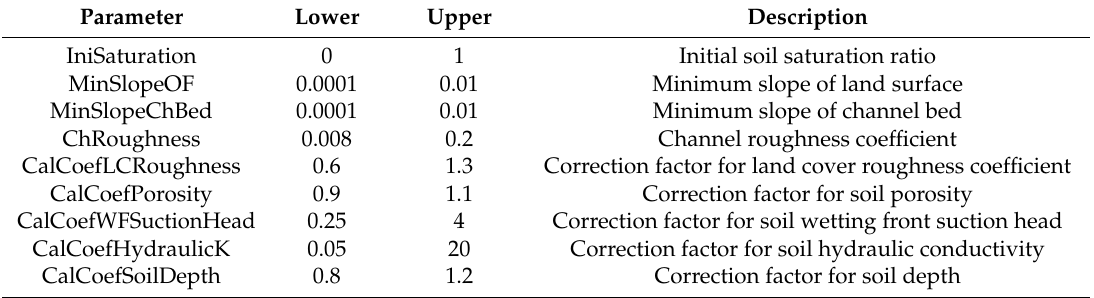
Table 1. Parameters of the grid-based rainfall–runoff model (GRM) to be calibrated using the shuffled complex evolution (SCE)